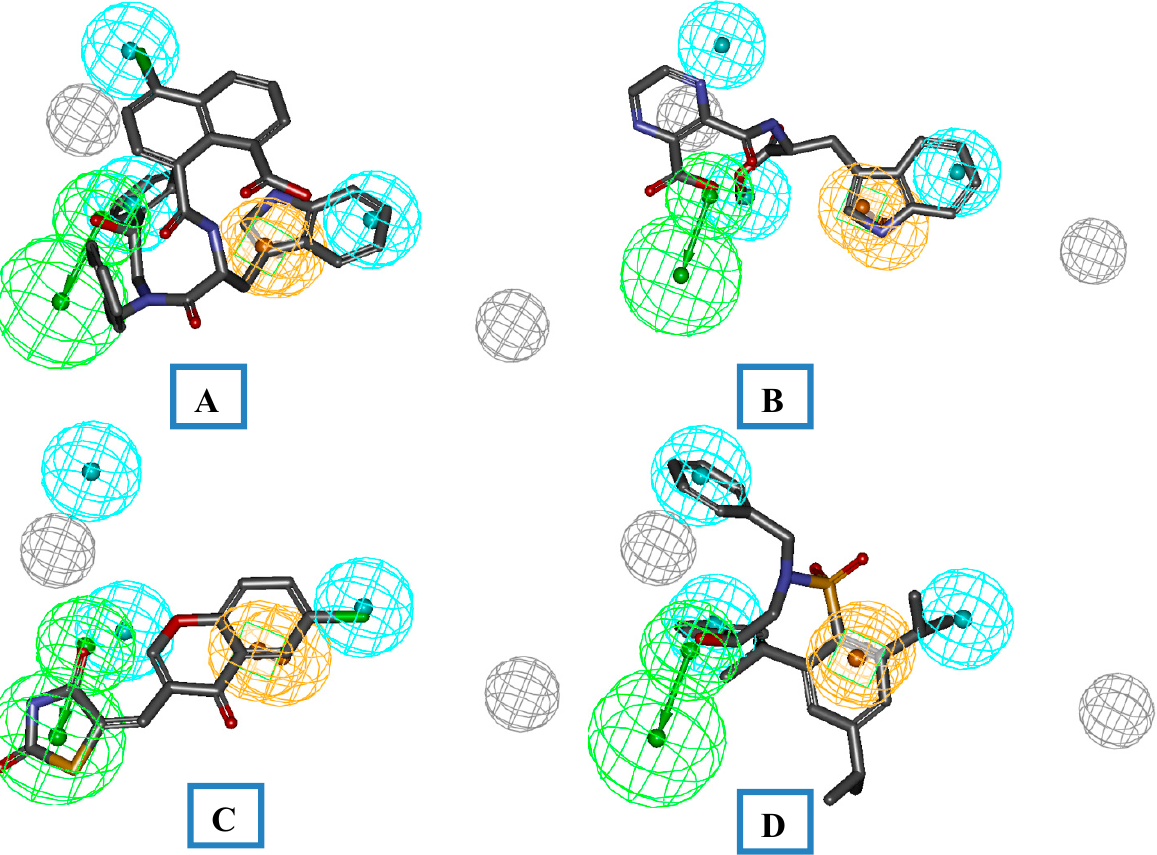
Figure 6. ( A , B ) The pharmacophore mapping of each identified core I (Compound 112 , fit value: 9.36382, and Compound 114 , fit value: 8.11322).( C ) Core II (Compound 128 , fit value: 7.36382). ( D ) Core III (Compound 125 , fit value: 9.12313).